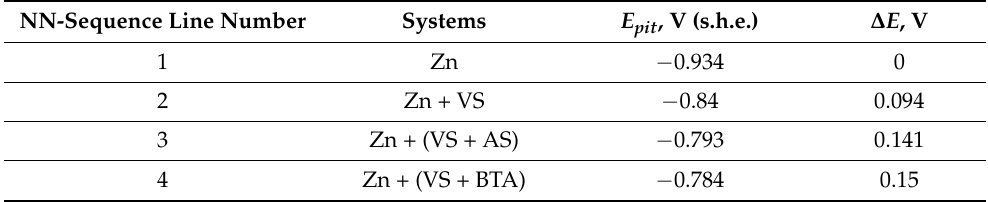
Figure 5. Zinc surface after taking the anodic polarization curve, ( a ) non-modified zinc; ( b ) zinc modified with a VS solution. Table 3. The effect of zinc surface modification on the value of pitting potential. NN-Sequence Line